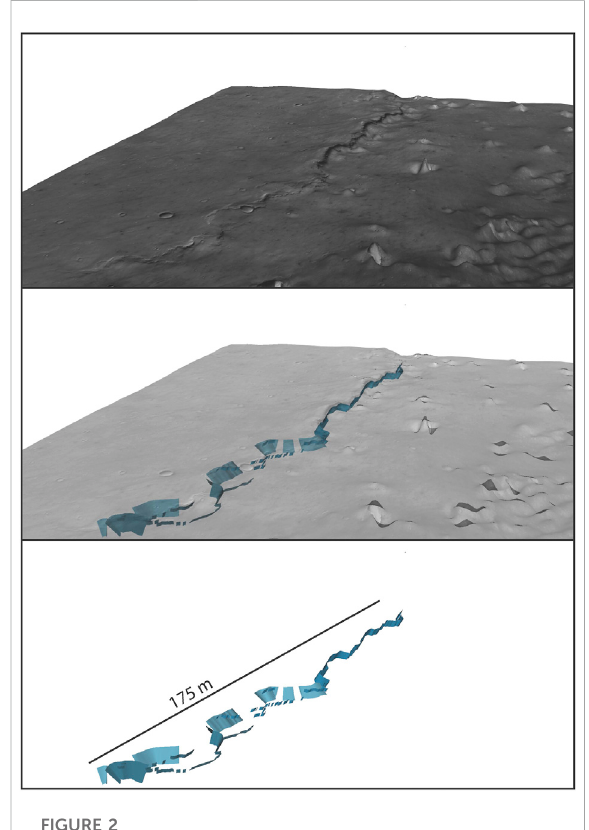
FIGURE 2 Thrust fault-related landform on Mars displayed in Move software. Context camera imagery was draped over Mars Orbiter Laser Altimeter topography and fault surface breaks were mapped and fault planes generated. The transition from simple, single planar fault in the north (upper right) to complex, shallow multi- fault system in the south (lower left) demonstrates how morphological variability can be interpreted through subsurface